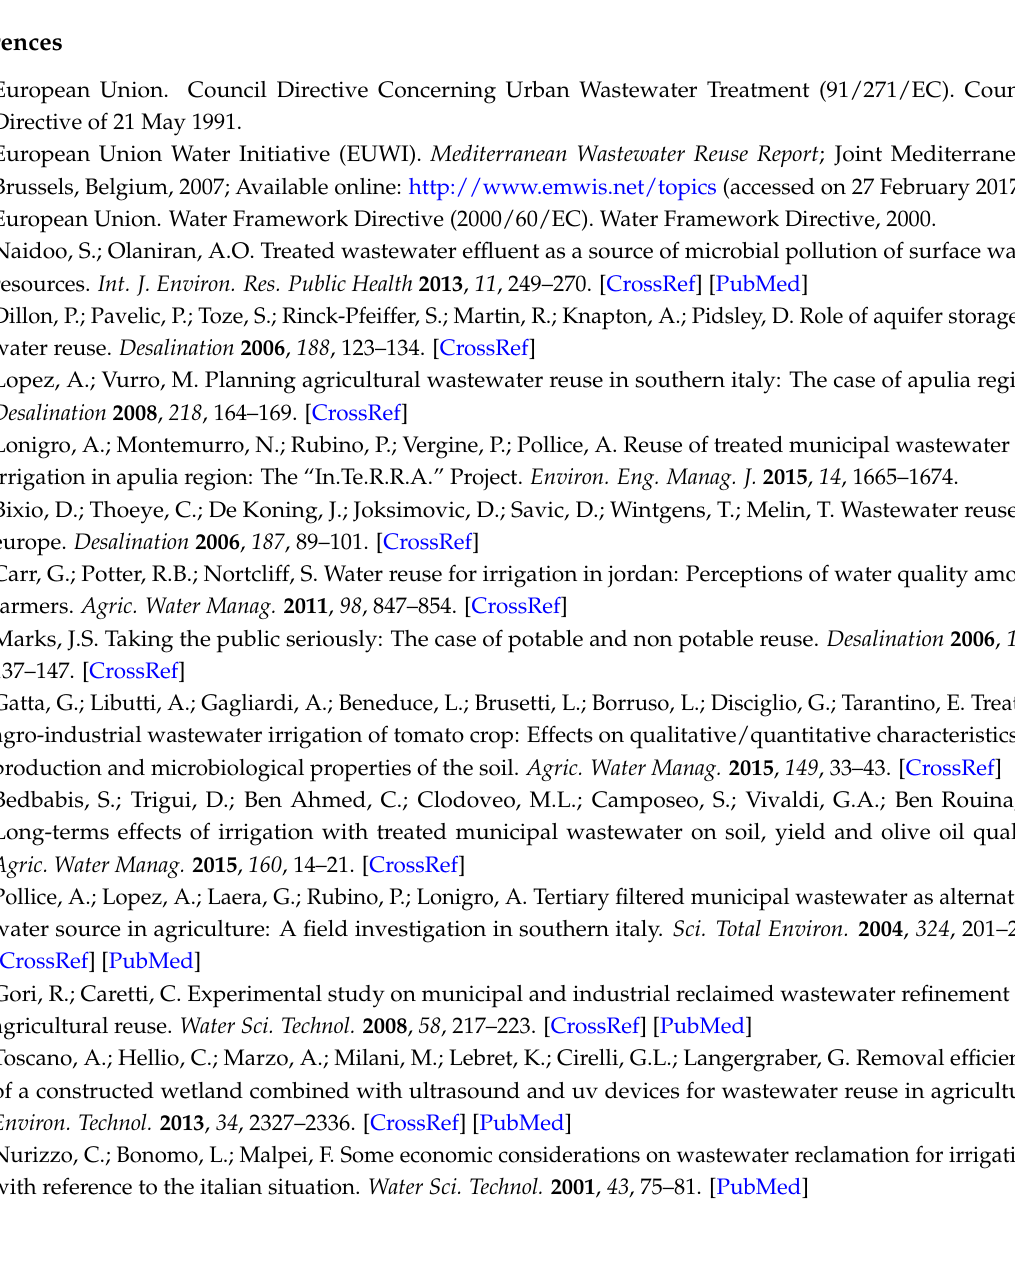
Table S1: Procedure and amounts used for the evaluation of costs. Author Contributions: Stefania Arborea, Vito Iacobellis and A. Ferruccio Piccinni conceived the economic appraisal of costs. Giacomo Giannoccaro and Bernardo C. de Gennaro conceived the economic appraisal of benefits. All authors made an equivalent contribution to the paper. Conflicts of Interest: The author declares no conflict of